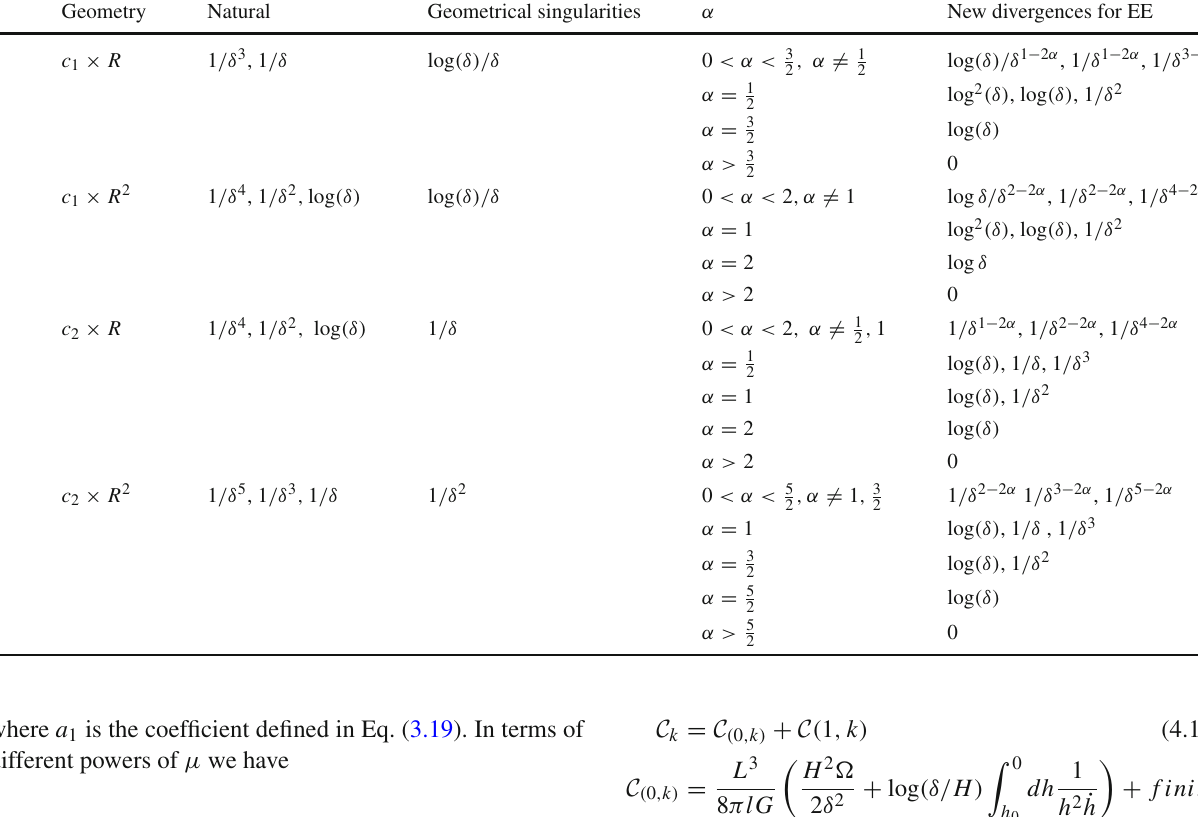
Table 3 Entanglement entropy for c n × R l d Geometry Natural Geometrical singularities α New divergences for